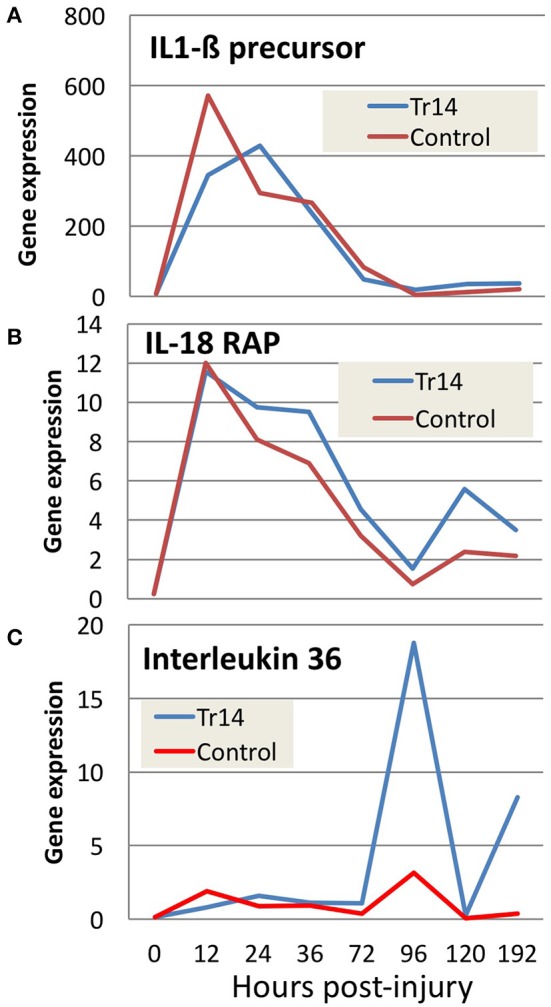
The effect of Tr14 on select transcripts in the interleukin pathway. RNA sequencing data was analyzed to identify transcripts modulated by Tr14 treatment. Significant increases in three of the transcripts (A–C) in the interleukin pathway are shown as gene expression (RPKM, Y axis) as a function of time in hours (X axis).